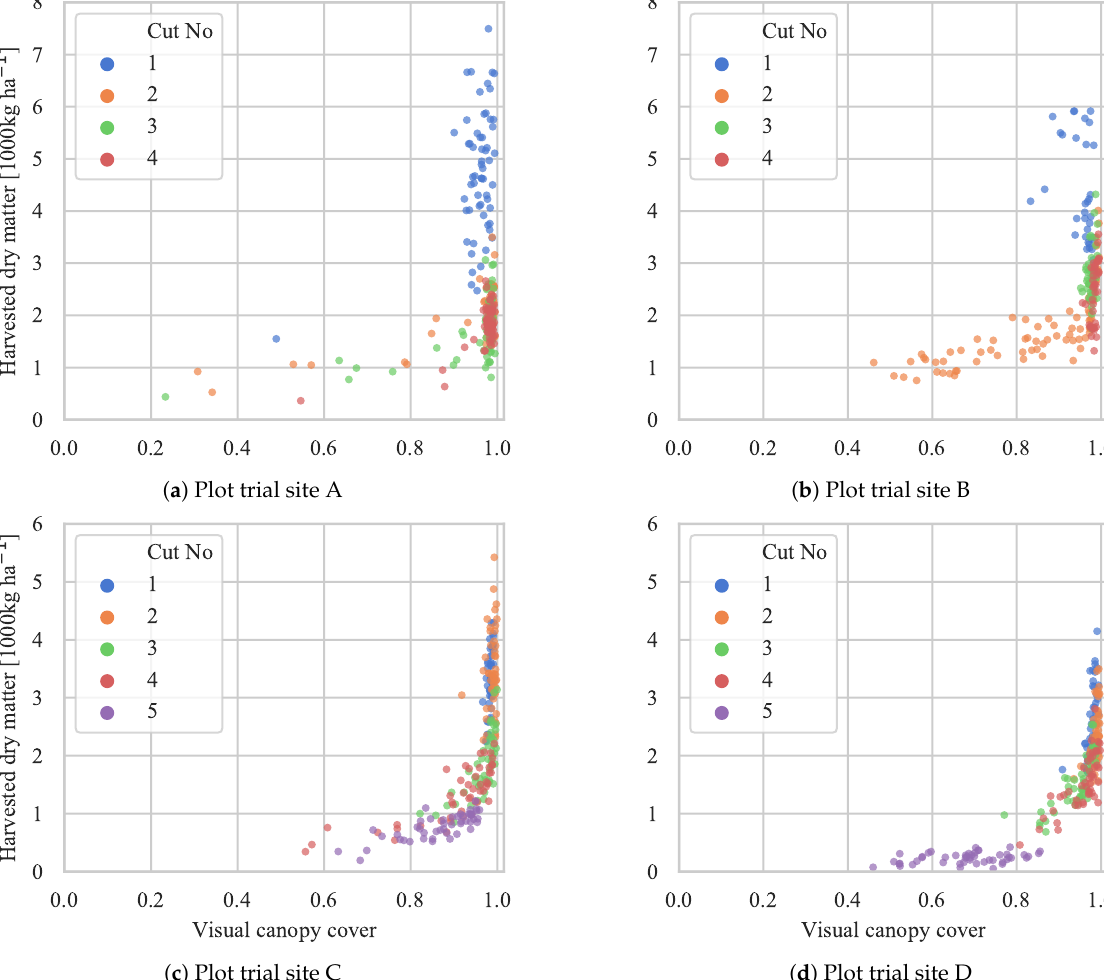
Figure 11. Comparison between the predicted visual canopy coverage and the corresponding yield in the biomass samples. The data are visualized for each plot trial site individually to emphasize local trends. ( a – d ) correspond to plot trial sites A, B, C, and D,